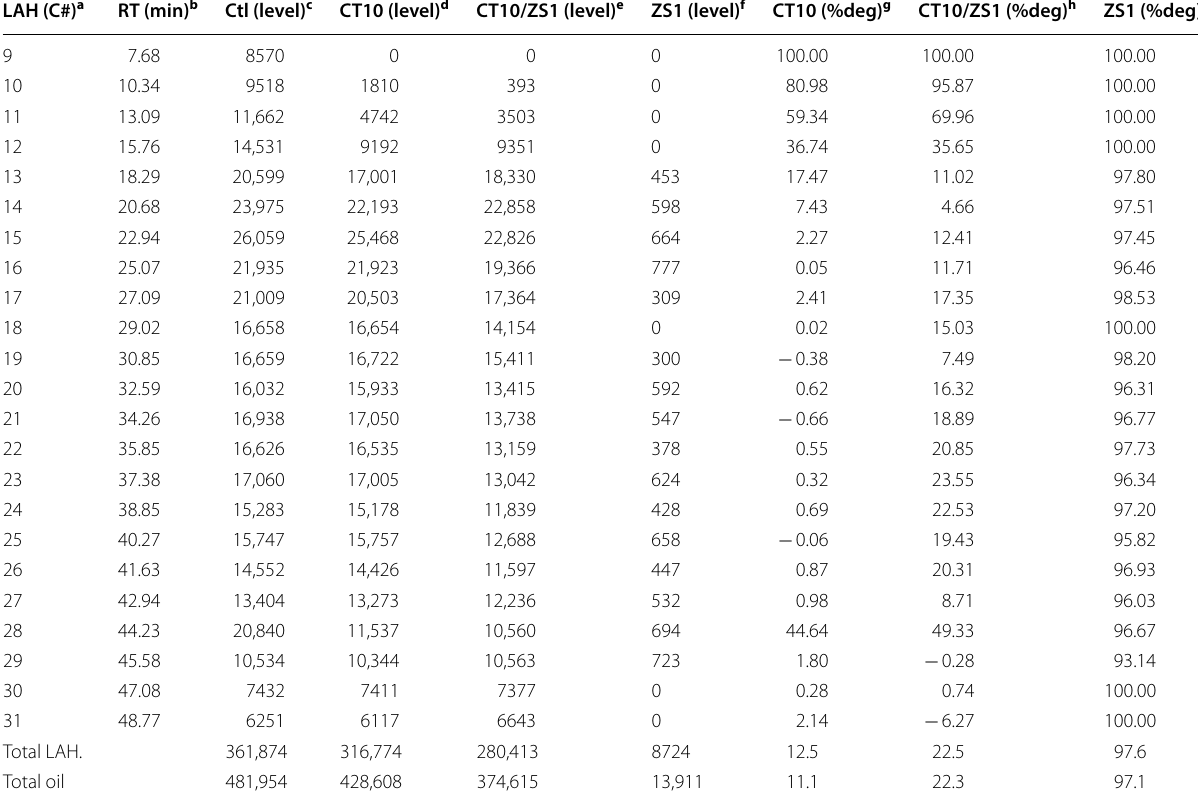
a LAH (C#) for linear aliphatic hydrocarbons with carbon numbers